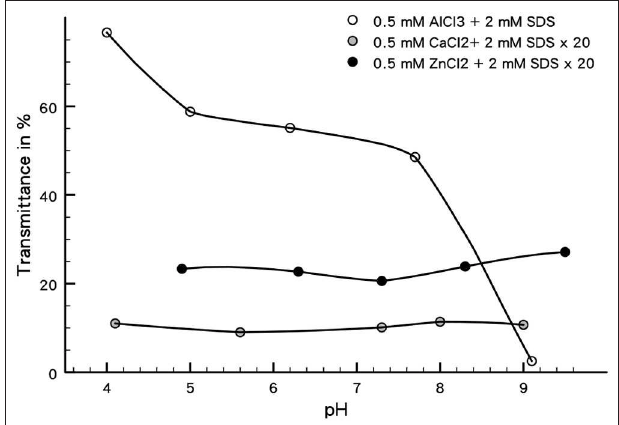
FIGURE 5 | Transmittance (at 800 nm) of the aqueous phase of the phase transfer experiments shown in Figure 4 . Note that the data for 0.5 mM CaCl 2 and ZnCl 2 have both been multiplied by a factor of 20 in order to make them visible with respect to the AlCl 3